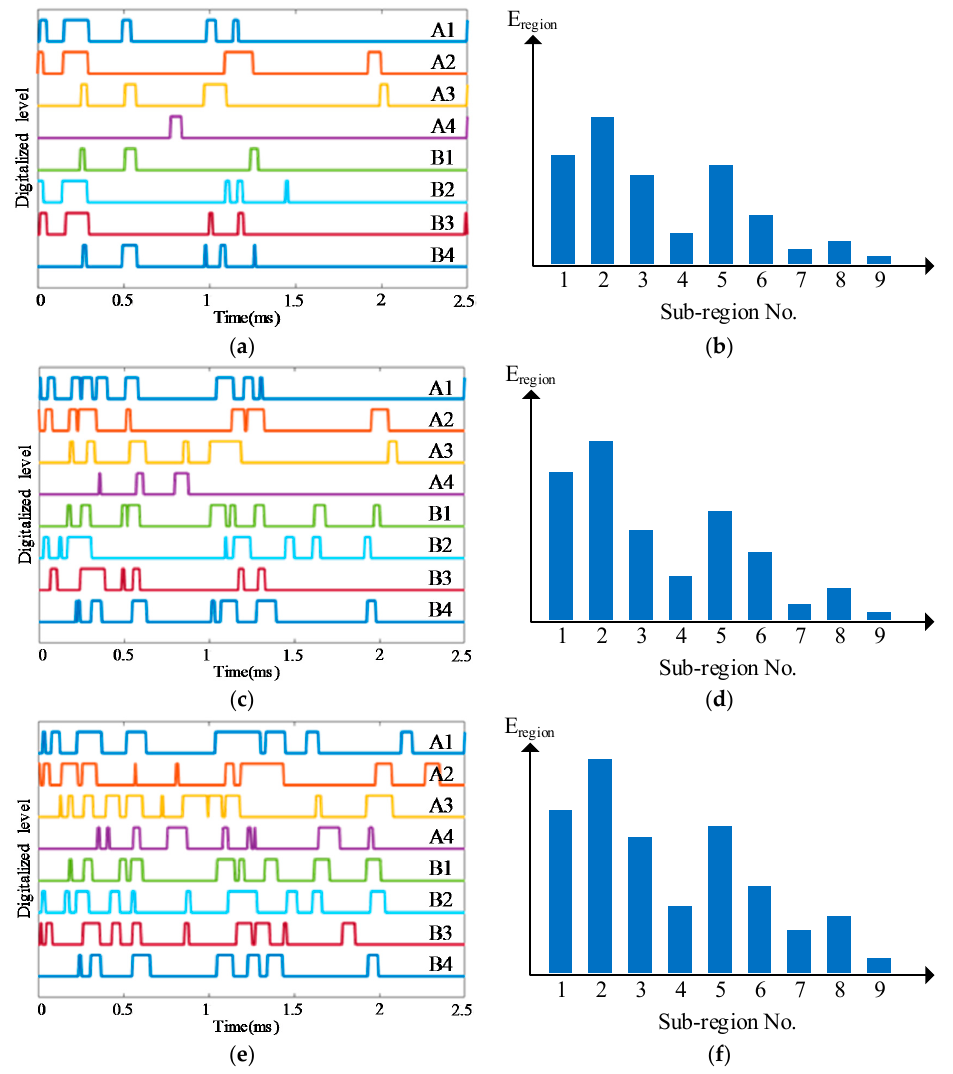
Figure 19. Typical impact region monitoring results on the glass fiber laminate plate based on CSSN under different energy levels: ( a ) CDSs and ( b ) E region of all sub-regions under energy level 1; ( c ) CDSs and ( d ) E region of all sub-regions under energy level 2; ( e ) CDSs and ( f ) E region of all sub-regions under energy level 3.